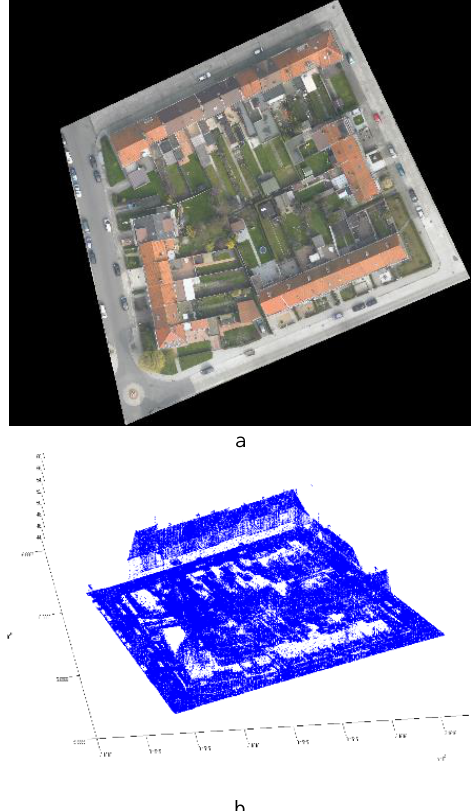
Figure 2. Study area. a. High resolution aerial orthophoto. b. High resolution LiDAR point cloud.